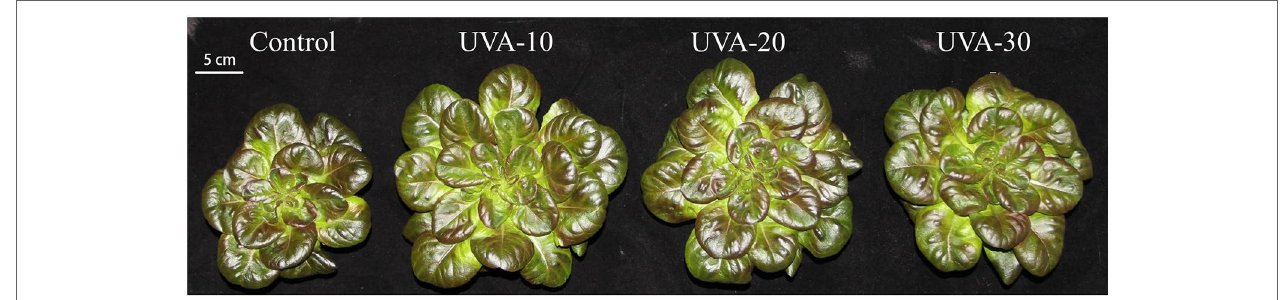
FIgURe 2 | Lettuce plants grown under four different light conditions 13 days after treatment. UVA-10, UVA-20, and UVA-30 represent treatments with 10, 20, and 30 µmol m −2 s −1 UVA radiation, respectively.